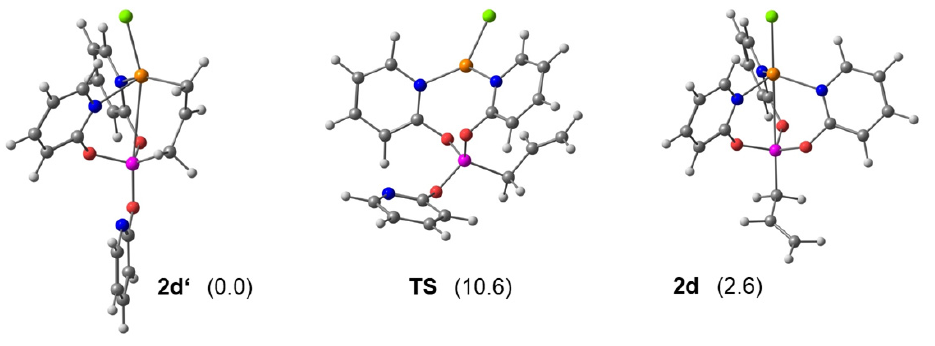
Figure 5. Optimized molecular structures of 2d ′ , 2d and the transition state ( TS ) for their interconversion with their relative Gibbs free energy (in kcal ⋅ mol − 1 ) in parentheses. version with their relative Gibbs free energy (in kcal · mol − 1 ) in